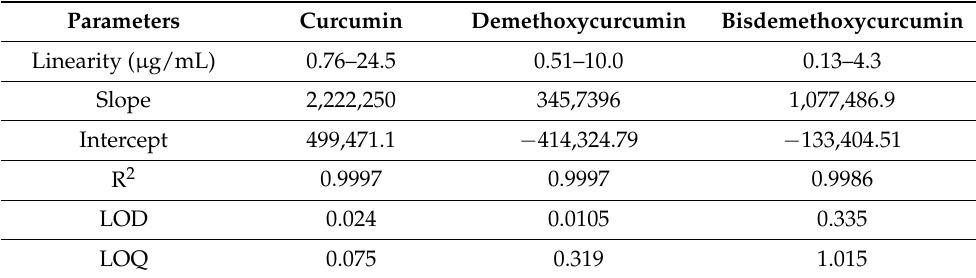
Table 6. Statistical parameters for individual calibration